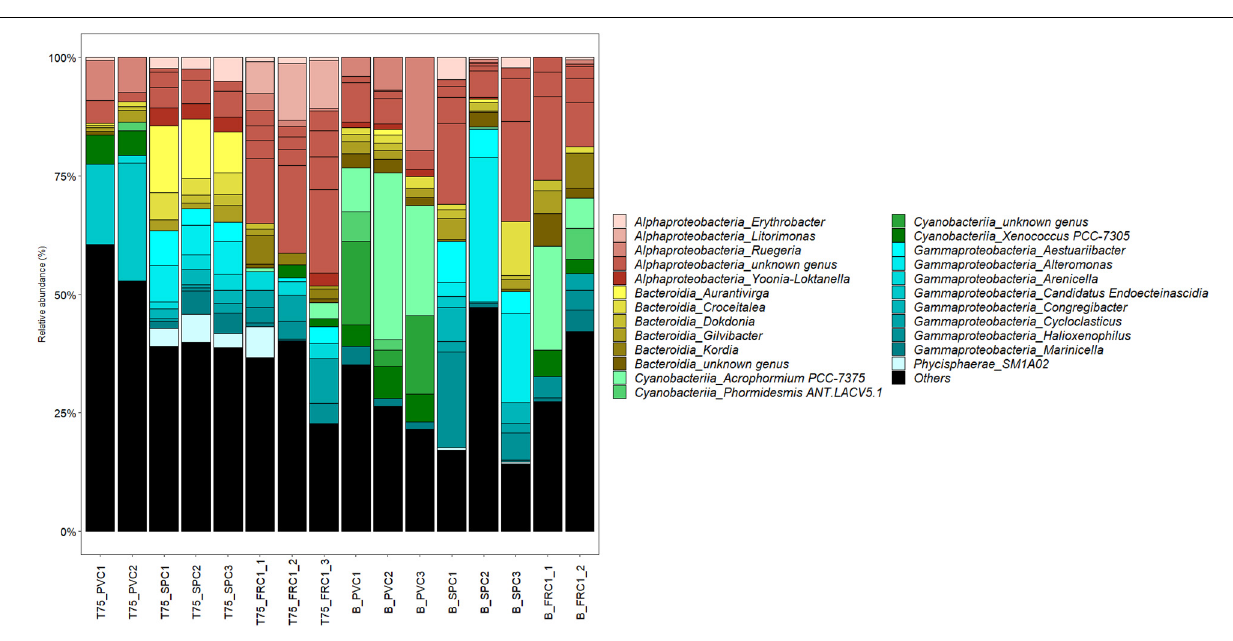
diversified communities than SPC ones immersed 10 cm